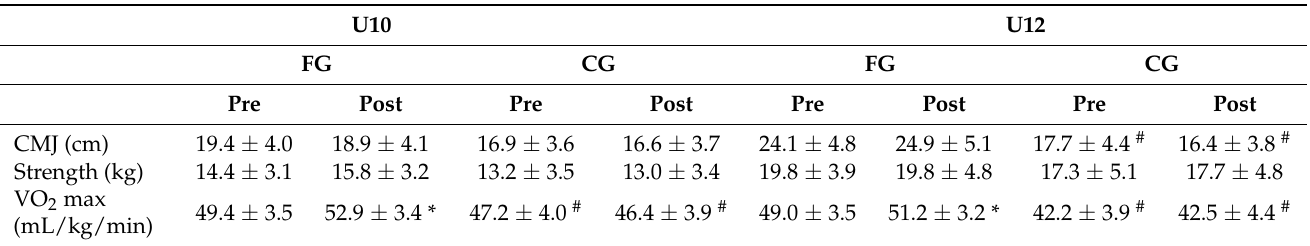
Table 2. Physical condition before (pre) and after (post) a 12-week intervention with two days of training football plus one match per week in young U10 and U12 players (FG) and without football training in young controls (CG).